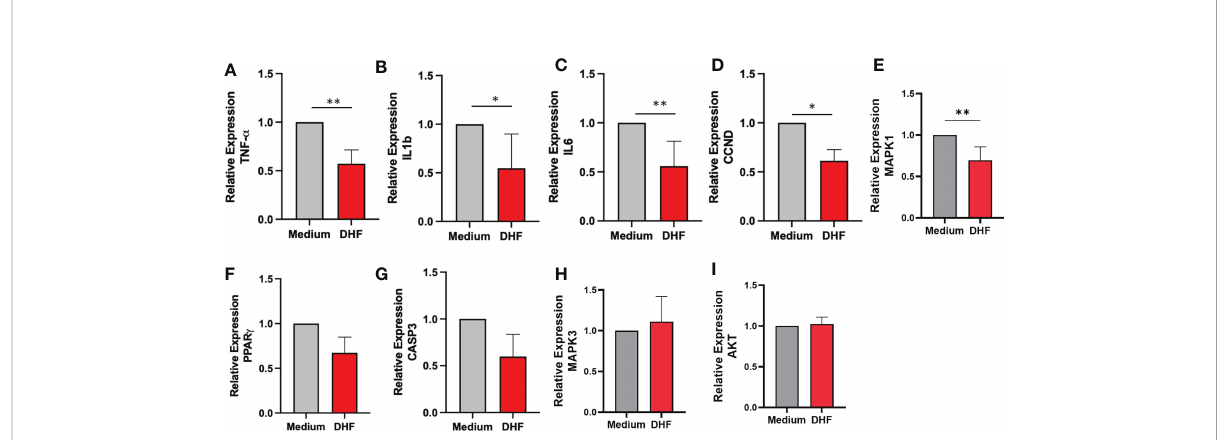
FIGURE 7 Effect of DHF on therapeutic target gene in esophageal biopsy sample: Based on the therapeutic hub targets predicted by the computational modeling, the expression levels of key targets were validated ex-vivo using human esophageal biopsy samples cultured in the presence of DHF. The relative expression levels of TNF- a (A) , IL1 b (B) , IL-6 (C) , CCND (D) and MAPK1 (E) were signi fi cantly inhibited in the presence of compound DHF. Similarly, the expression levels of PPAR g (F) , CASP3 (G) , MAPK3 (H) and AKT (I) showed no signi fi cant difference as compared to the medium. Data represents Mean ± SEM. N = 6-8 samples. *p < 0.05; **p < 0.01 compared to Medium. Paired t test was used for statistical